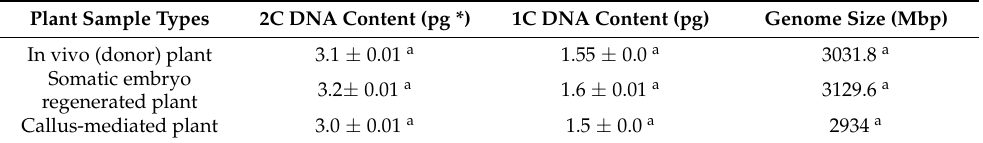
(somatic embryo regenerated and callus-mediated plants) and donor plants of D. purpurea .